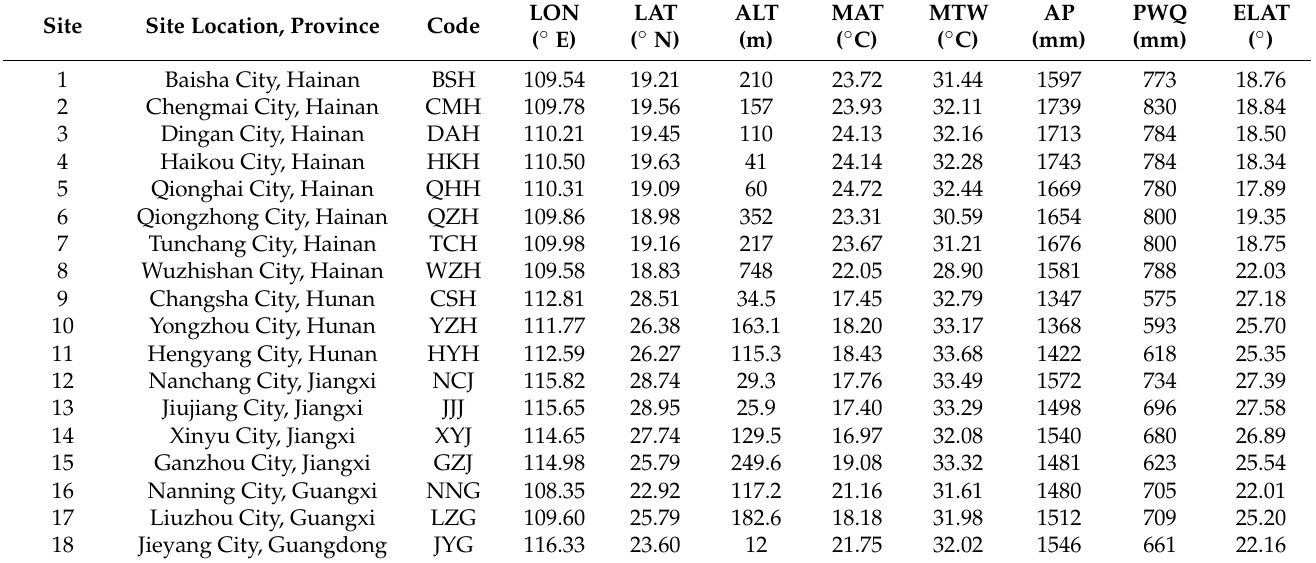
Table 1. The geographical and climatic variables of the 18 study sites of Camellia oleifera in south China.